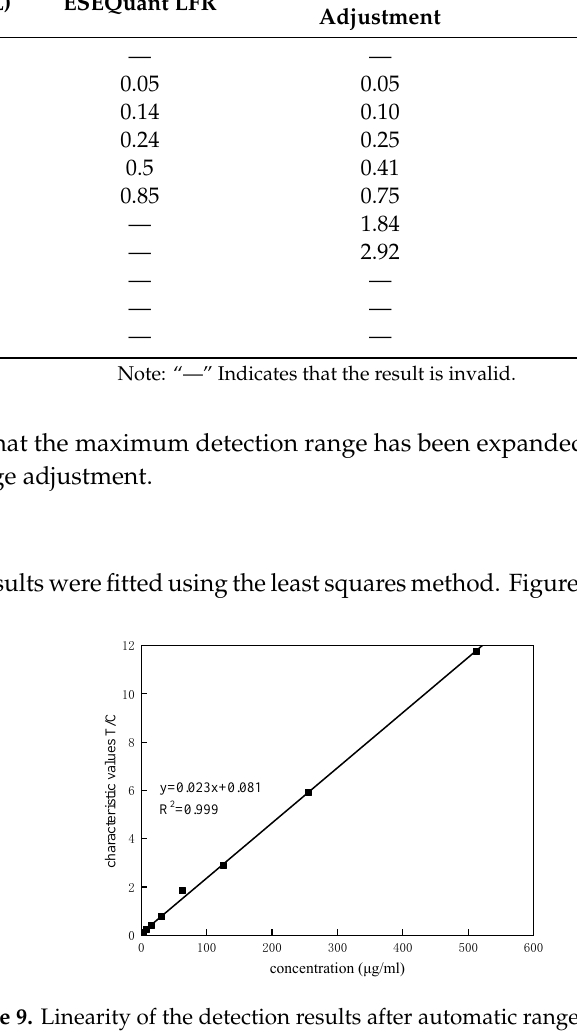
Table 1. Comparison of detection ranges of C-reactive protein (CRP) solution between the ESEQuant Lateral Flow Reader (LFR) and the FICA reader after automatic range adjustment.